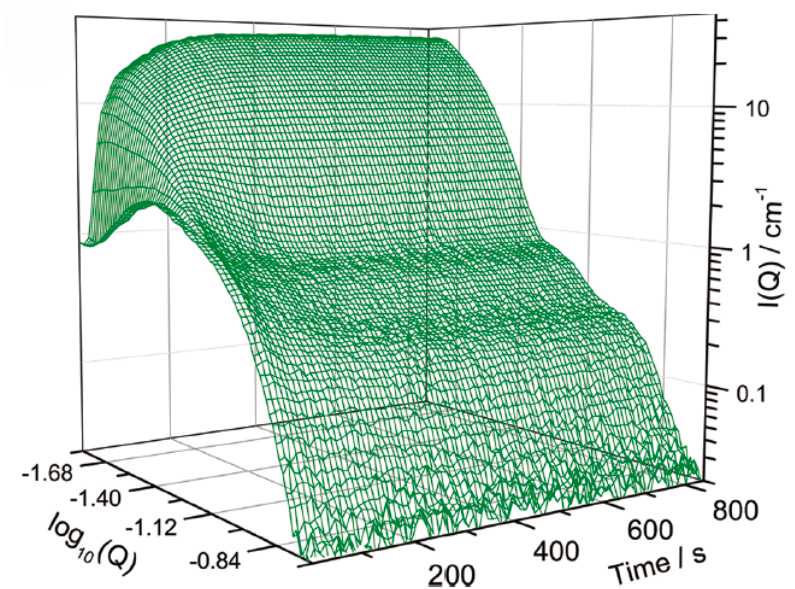
Figure 1. Time-resolved SANS data from the surfactant templated formation of mesoporous silica nanoparticles. This is one of the fastest neutron scattering experiments reported so far. A time- resolution of 10 s/frame rendered analyzable data (reproduced with permission from [7], American Chemical Society, 2012).